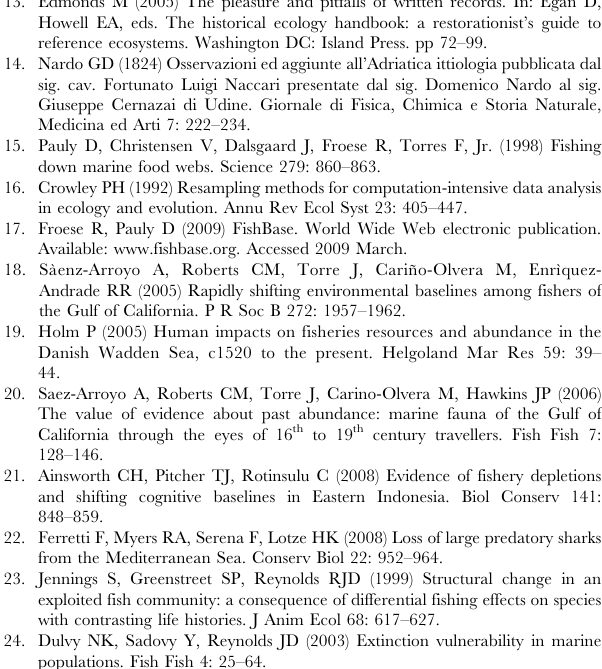
Table S1 List of naturalists’ books that were analyzed. (DOC) Table S2 Sources of landing data. (DOC) Table S3 Taxonomic groups for which landing statistics were available for the periods 1876–1900, 1901–1925 and 1926–1950. Table S4 Class limits (median and interquartile range) for each period of intercalibration and for the entire period with